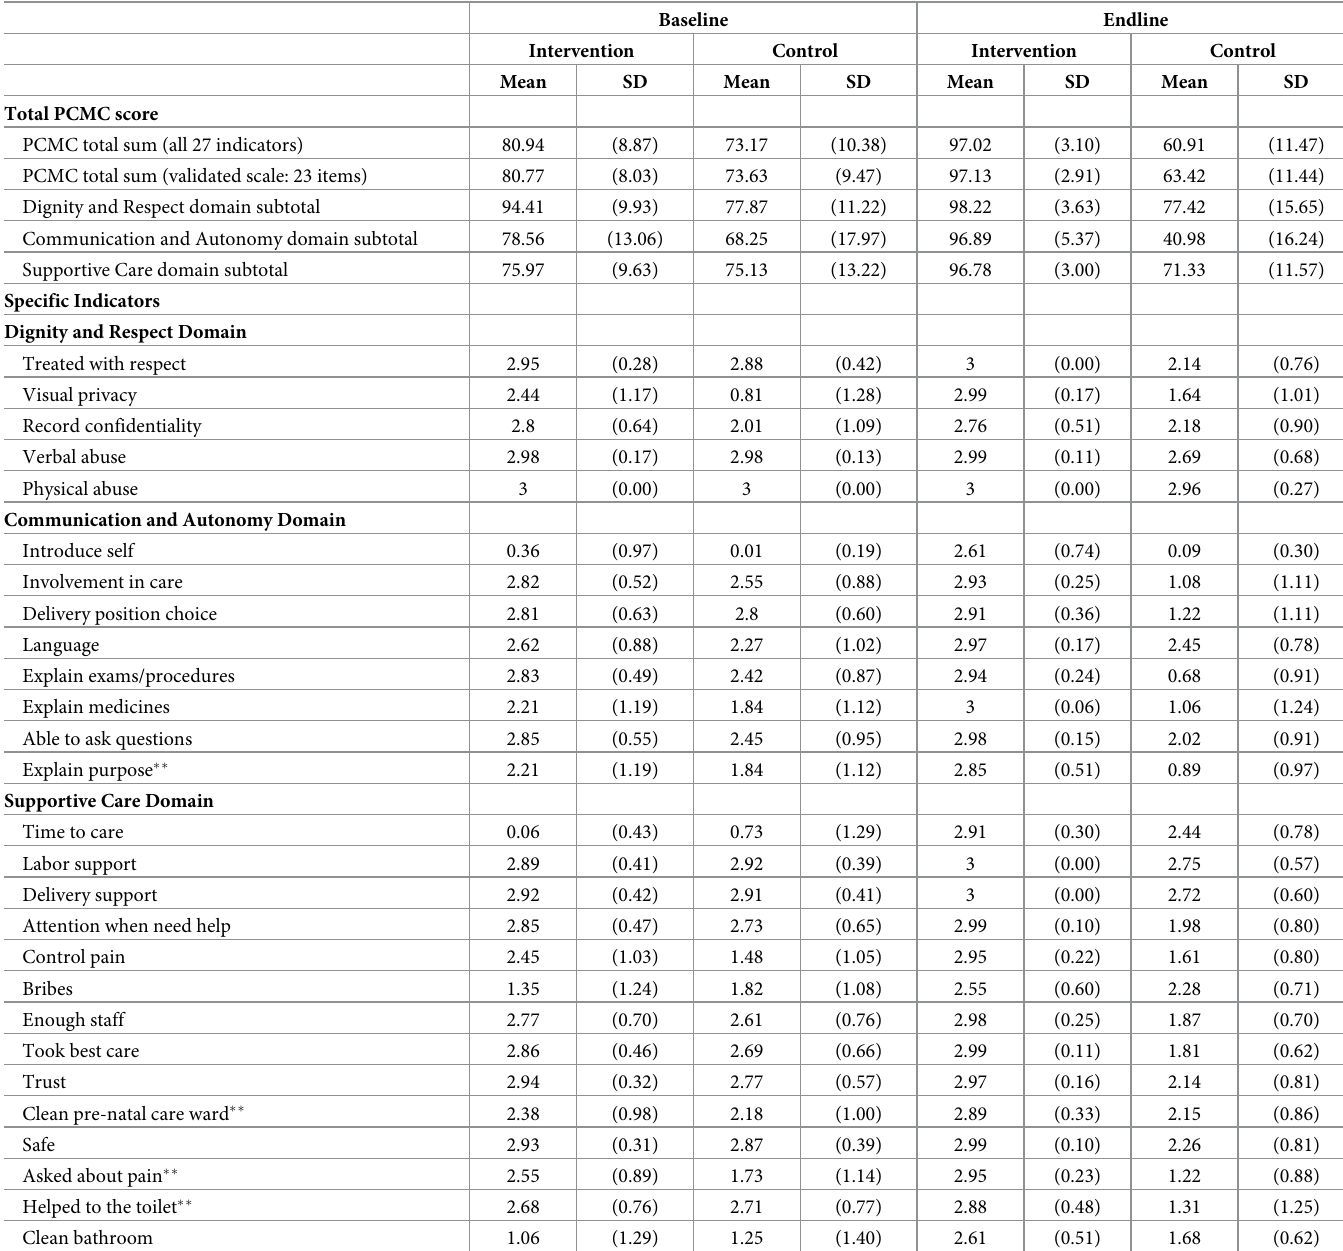
Table 2. Baseline-endline